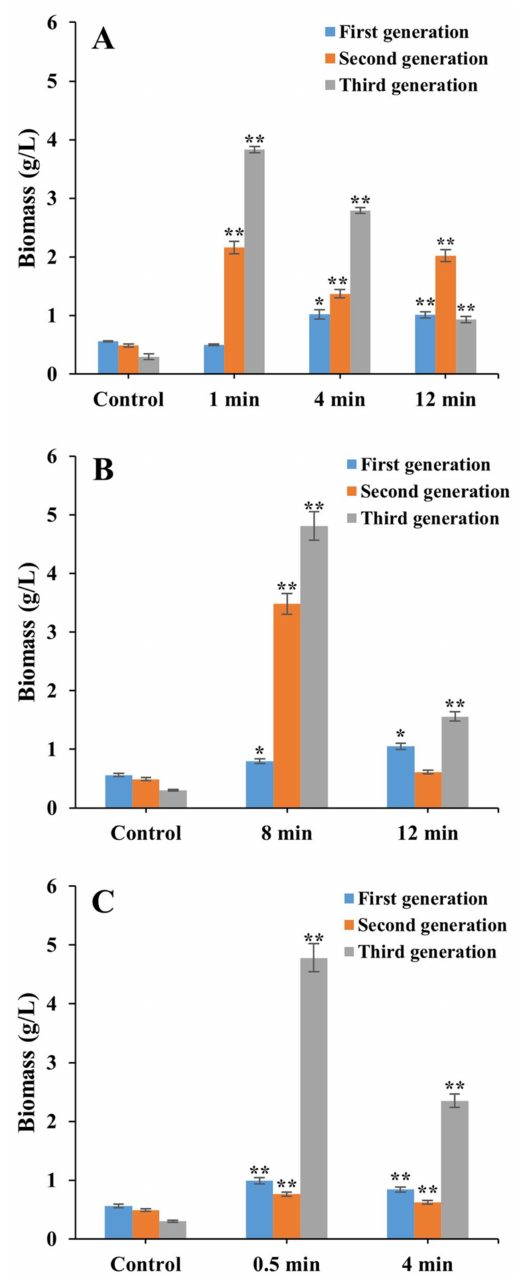
Figure 3. Biomass of laser mutants of Chlorella vulgaris strain FACHB 9 derived from the treatment of He–Ne ( A ), Nd:YAG ( B ), and SC ( C ) cultured under a heterotrophic condition for 21 days (three generations). Data are presented as mean ± standard errors ( n = 3). Symbols “*” and “**” indicate statistically significant differences compared to controls at p < 0.05 and p < 0.01,